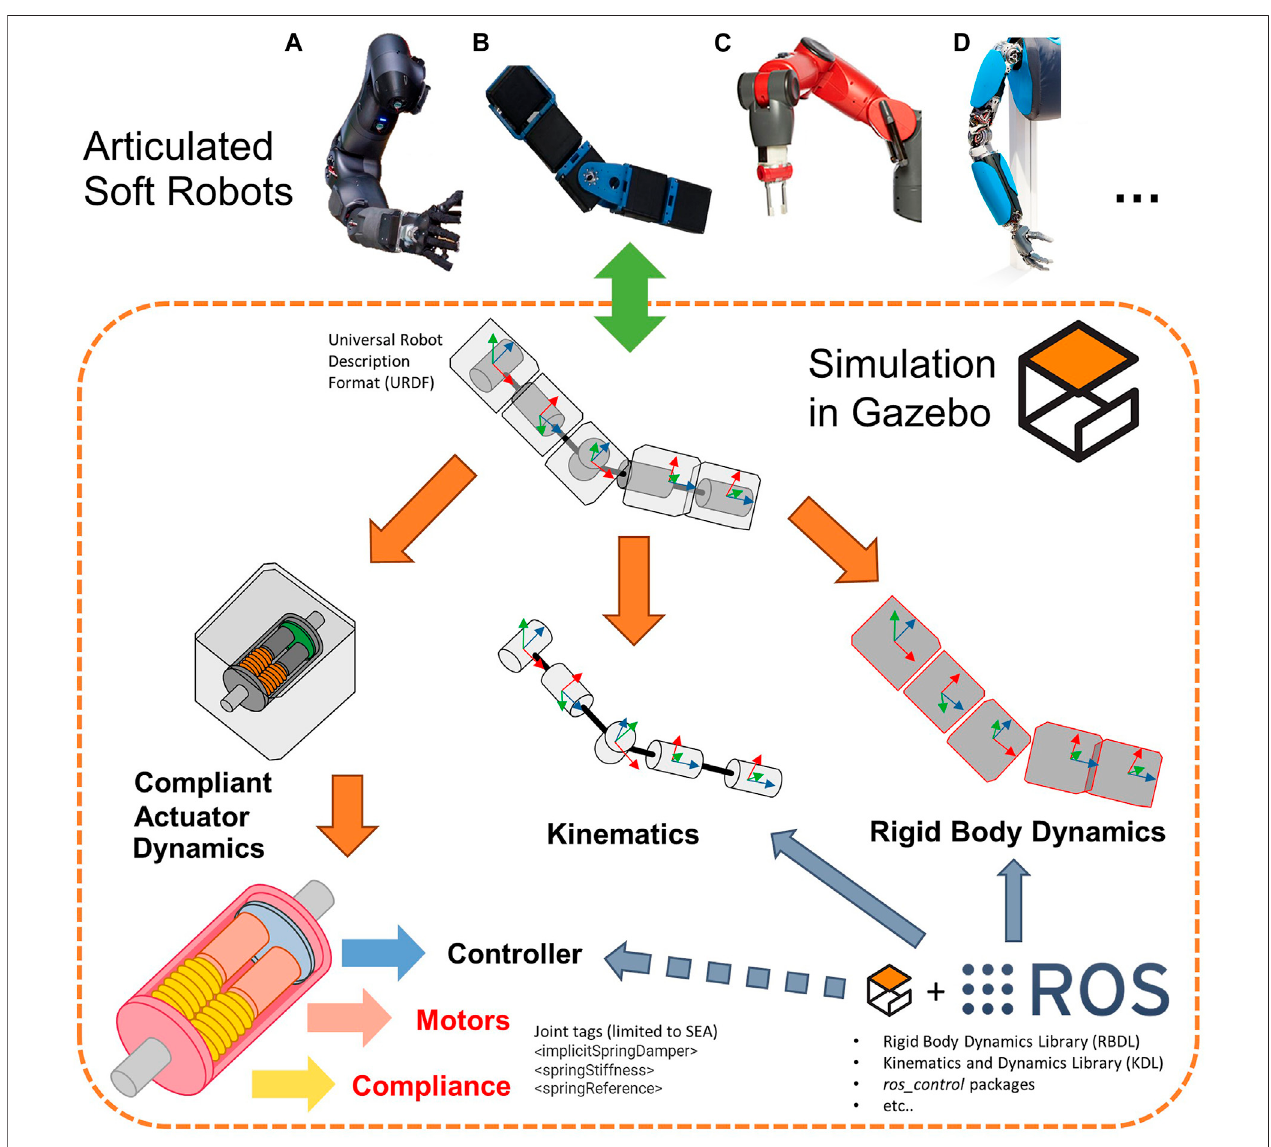
FIGURE1| AvailablesolutionsforsimulatinginGazebothekinematicsandthedynamicsofASRs,suchas, (A) WalkMan ’ arm(Negrelloetal.,2015), (B) AlterEgo ’ s arm (Lentini et al., 2019), (C) Baxter ’ s arm (Guizzo and Ackerman, 2012), and (D) Hand-Arm system (Grebenstein et al., 2011). The tools for simulating the compliant- actuated and the motor dynamics are, however, limited to a few simple cases, i.e., the SEA ones. The proposed toolbox allows to reliably simulate also the dynamics of more complex ASRs.